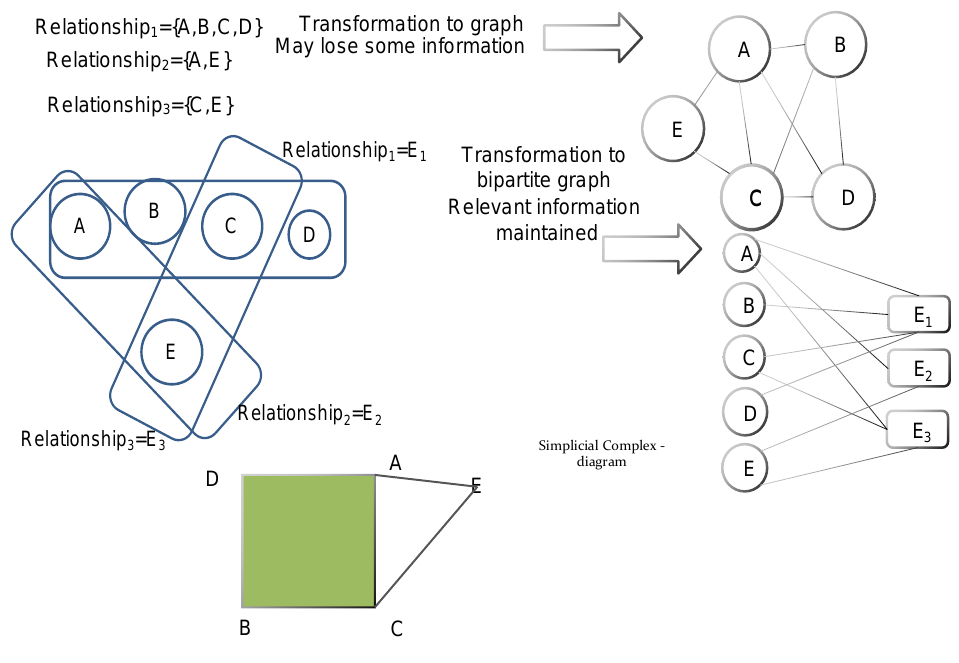
Figure 8. Hyper-graph representation of essential building blocks of the architecture of an IS Rela- tionships among entities (group of attributes of data collections).